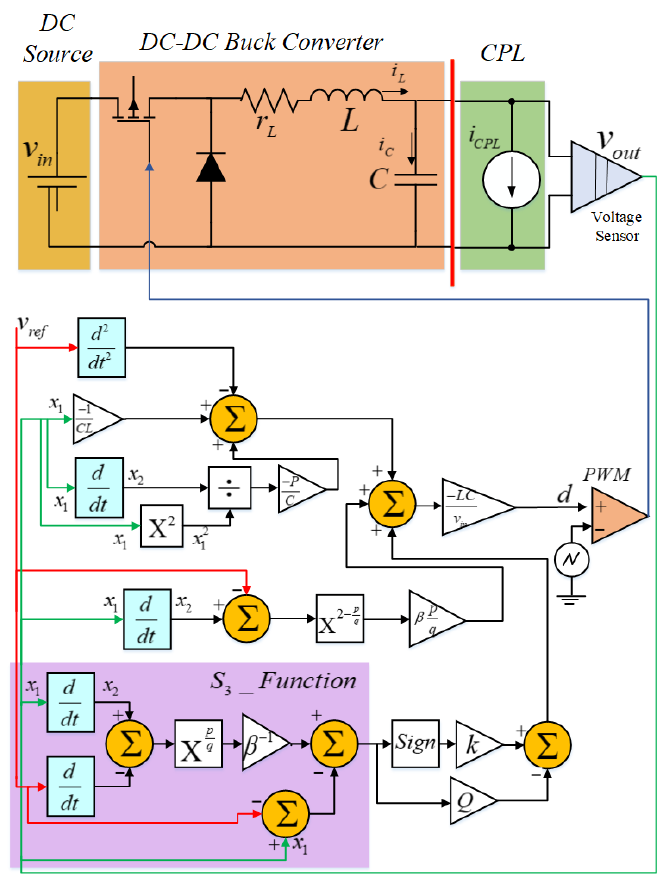
Figure 8. Block diagram of the NTSM controller applied for a buck converter supplying a CPL.